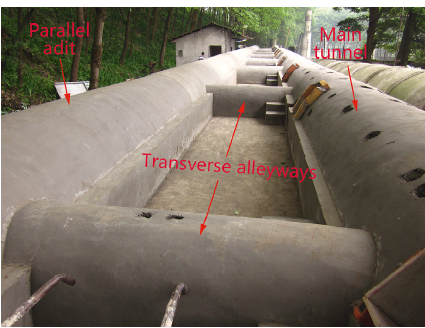
Figure 3: Actual model tunnel.